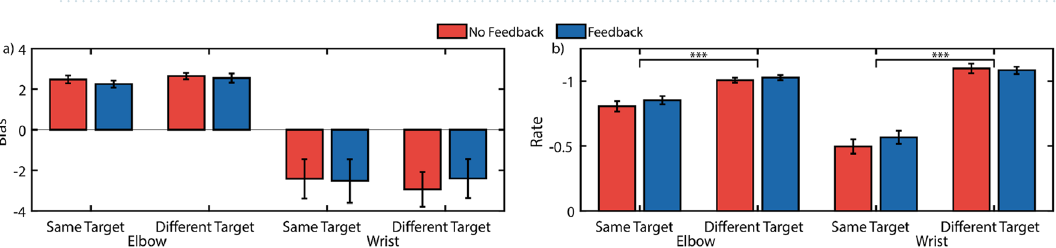
Figure 4. Non-Amputee Endpoint and Joint Angle Errors. Endpoint and joint angle errors vary moderately by target, and elbow errors were lower when making repeated reaches towards the same target, but no consistent differences were found between feedback conditions. Error bars indicate standard error of the mean. ( a – c ) Errors while reaching towards the same target for endpoint ( a ), position-controlled elbow ( b ), and myoelectric- controlled wrist ( c ). ( d – f ) Errors while reaching towards different targets for endpoint ( d ), elbow ( e ), and wrist ( f).